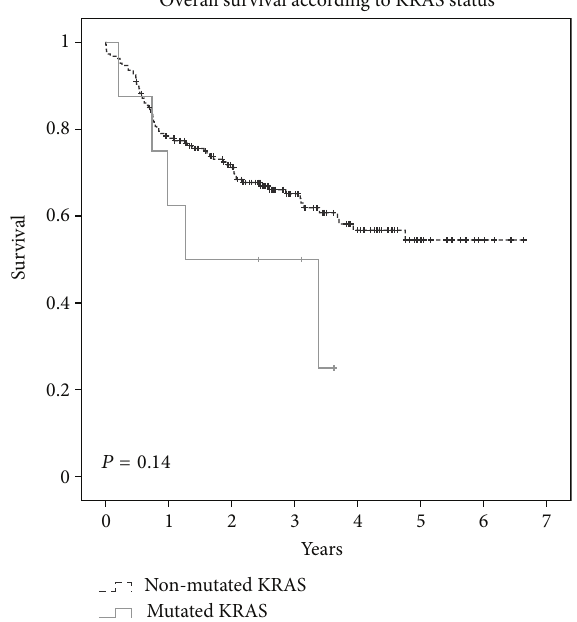
Figure 1: Kaplan Meier projected overall survival of wild-type K- RAS compared to mutated